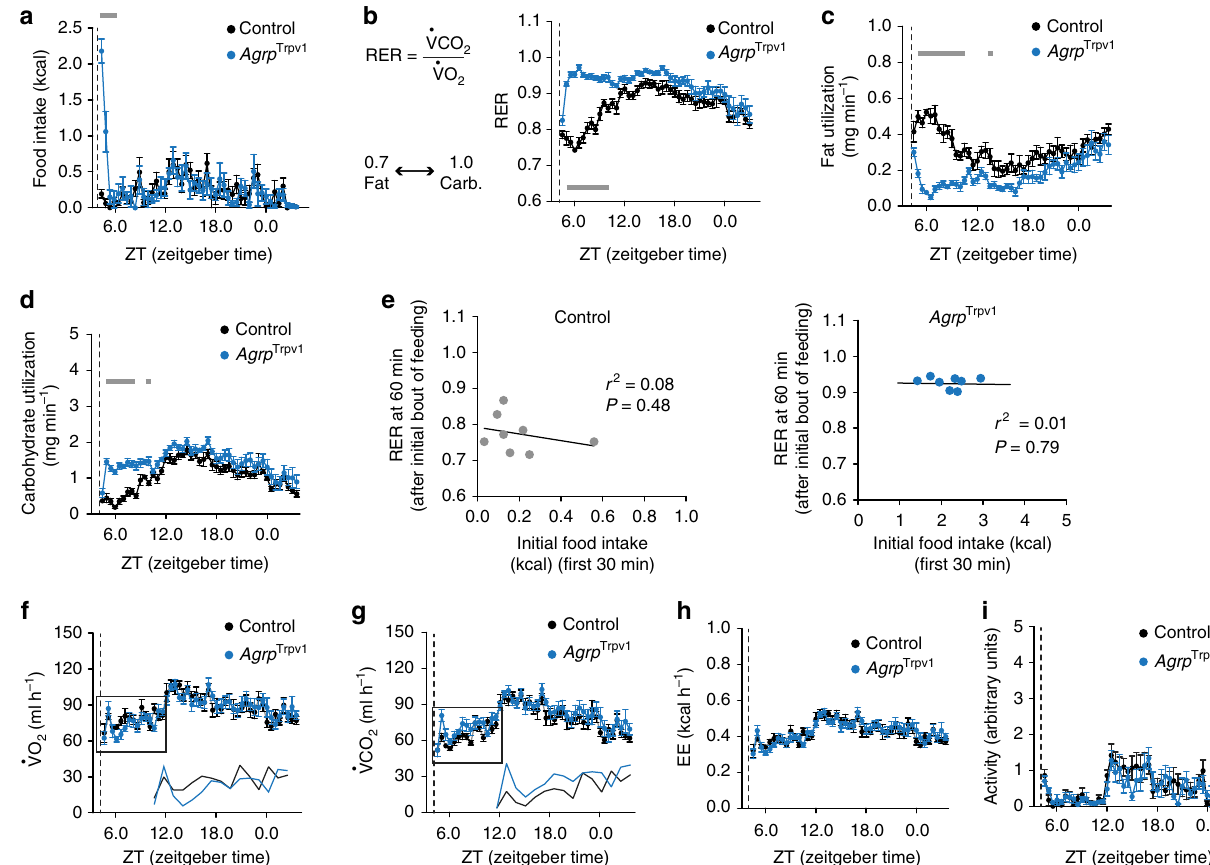
Fig. 1 Rapid shift in substrate utilization upon activation of agouti-related peptide (Agrp) neurons. a Food intake. b Respiratory exchange ratio (RER) (interaction: F 45,630 = 8.40, P < 0.0001; time: F 45,630 = 13.86, P < 0.0001; group: F 1,14 = 52.59, P < 0.0001). c Calculated fat utilization (interaction: F 45,630 = 6.44, P < 0.001; time: F = 7.22, P < 0.0001; group: F = 33.83, P < 0.0001). d Calculated carbohydrate utilization (interaction: F = 2.77, P < 45,630 1,14 45,630 0.0001; time: F 45,630 = 18.48, P < 0.0001; group: F 1,14 = 16.73, P = 0.001). e Linear regression analysis between the size of the initial bout of food intake ( fi rst 30 min) and RER (at the 60 min measurement) in control and Agrp Trpv1 mice. f VO 2 (interaction: F 45,630 = 1.07, P = 0.34; time: F 45,630 = 11.22, P < 0.0001; group: F 1, 4 = 0.01, P = 0.89). g VCO 2 (interaction: F 45,630 = 0.88, P = 0.68; time: F 45,630 = 15.07, P < 0.0001; group: F 1,14 = 1.58, P = 0.22). In f and g , inserts show the mean VO 2 and VCO 2 . h Energy expenditure (interaction: F 45,630 = 0.96, P = 0.53; time: F 45,630 = 12.09, P < 0.0001; group: F 1,14 = 0.02, P = 0.87). i Ambulatory activity (interaction: F = 0.80, P = 0.81; time: F = 6.02, P < 0.0001; group: F = 0.31, P = 0.58). Statistical 45,630 45,630 1,14 analysis was performed using two-way analysis of variance (ANOVA) with time as a repeated measure followed by Holm – Sidak ’ s multiple comparisons test (MCT). Gray bars indicate time points in which MCTs were statistically signi fi cant ( P < 0.05). From a – i control (black; n = 8) and Agrp Trpv1 mice (blue; n = 8). Dashed line indicates time of capsaicin injection. Symbols indicate mean ±